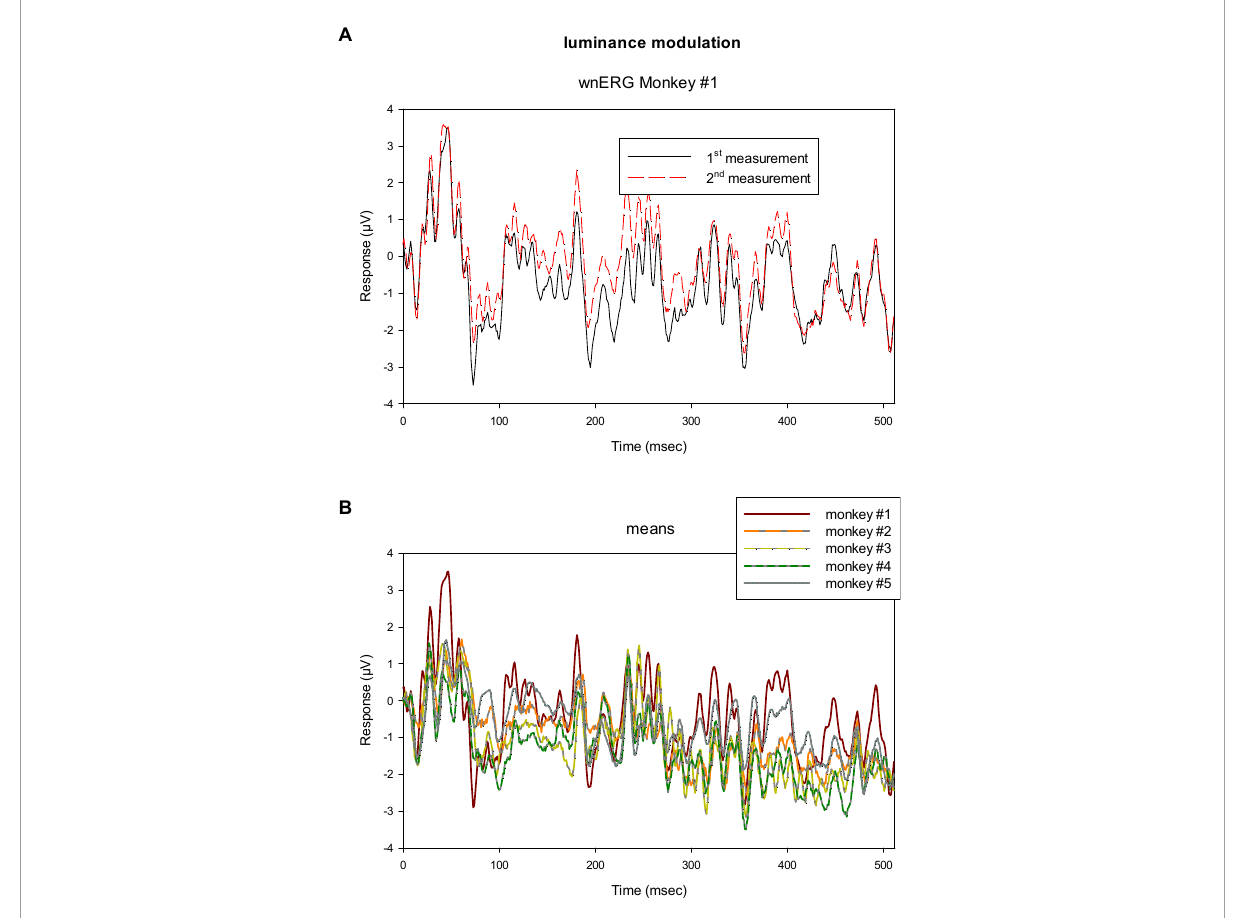
FIGURE5 (A) Two sequential recordings with luminance TWN in monkey #1 showing that the responses were highly reproducible. (B) Means of two recordings to luminance TWN stimuli in five different monkeys. The responses show similar features for all animals although the differences are larger than those found between the two measurements within monkey